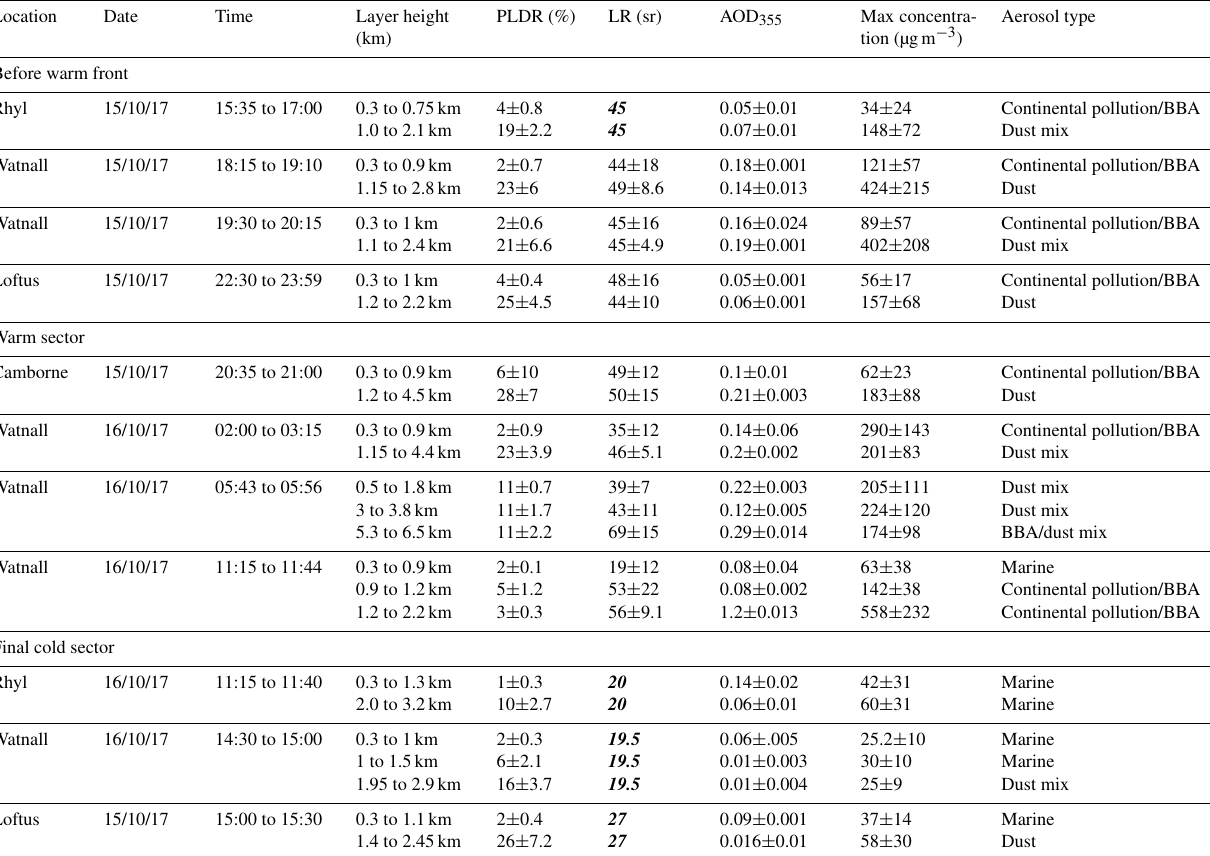
Table 2. Summary of lidar retrievals. Values of AOD, LR, and PLDR are at 355nm. Please see text for an explanation of sector descriptions.